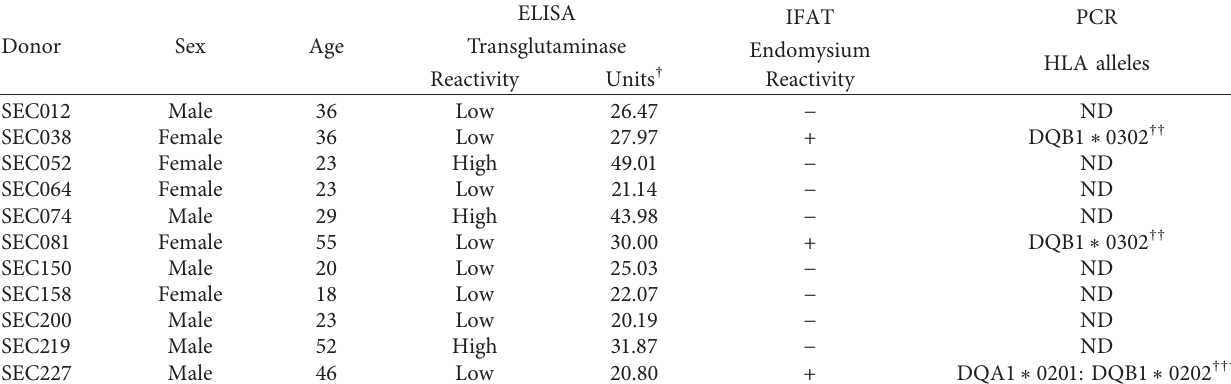
Table 1: Summary of seroreactive